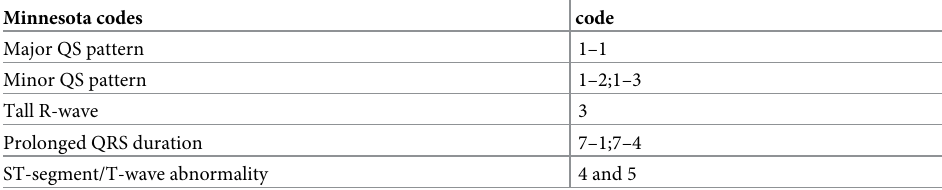
Table 1. Categories of Minnesota